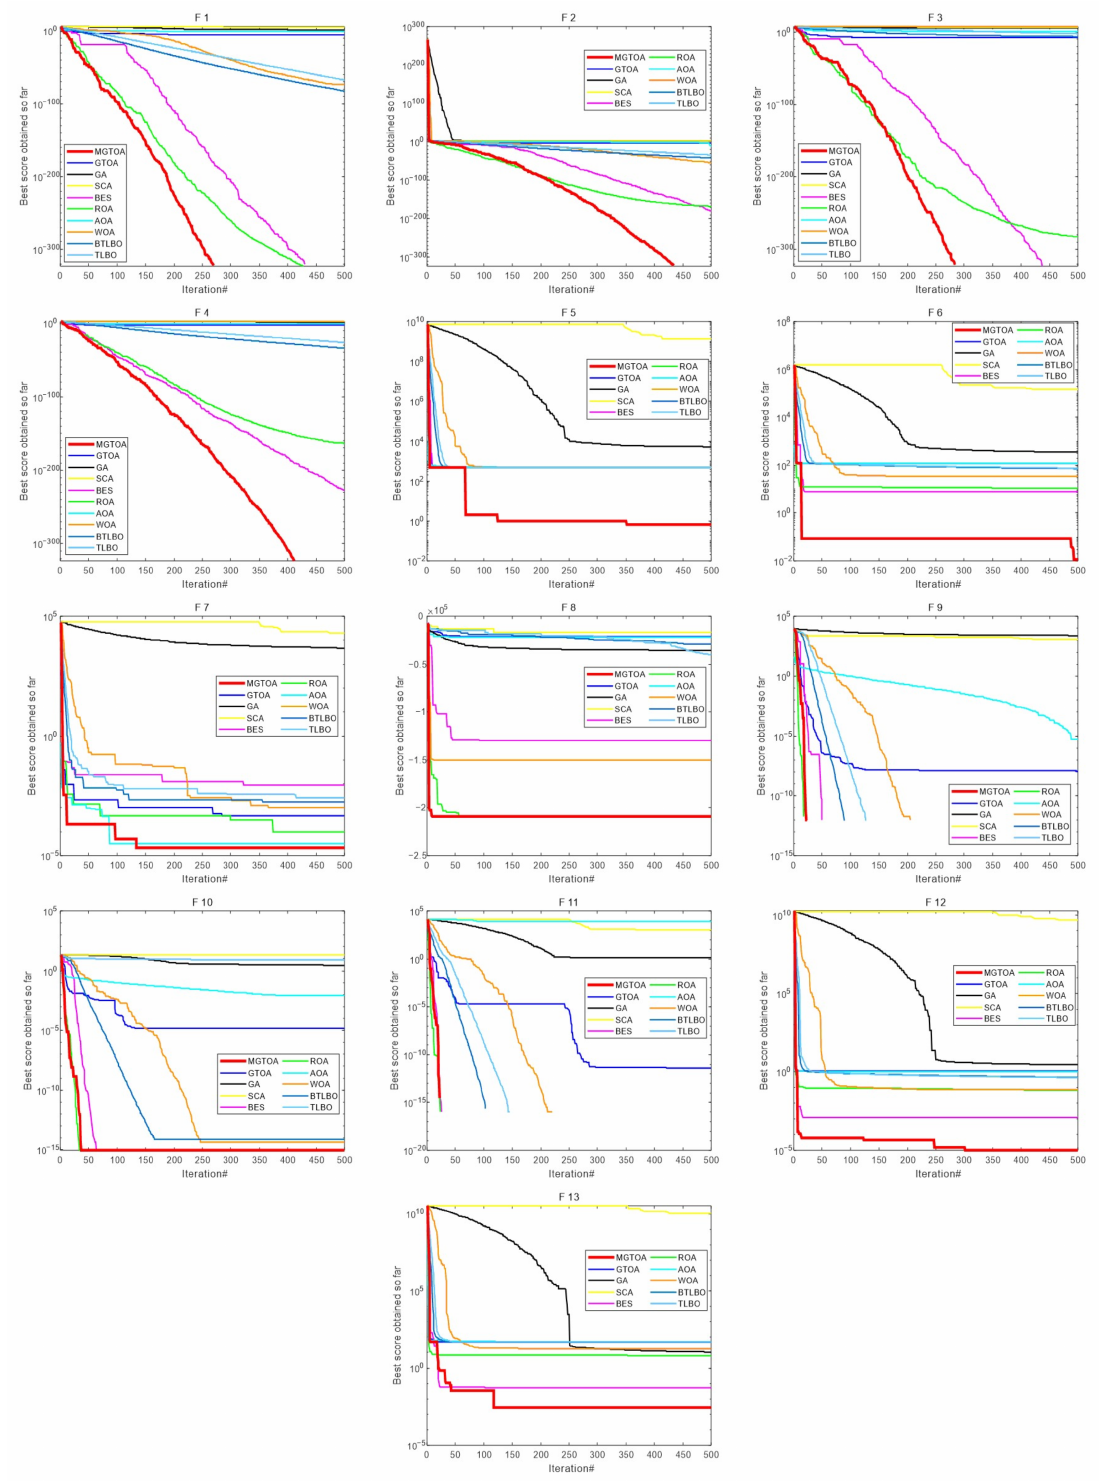
Figure 5. Convergence curves for the optimization algorithms for standard benchmark functions (F1–F13) with dim =